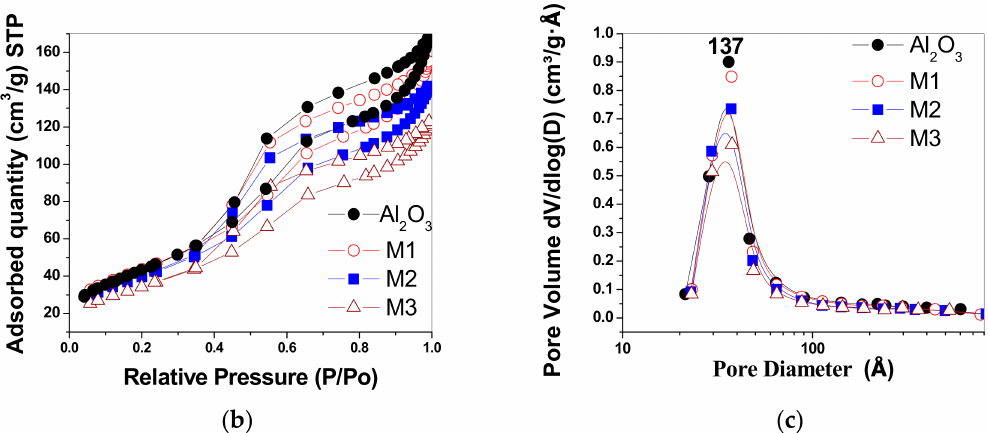
Figure 3. ( a ) SEM micrographs of alumina samples and supported birnessite. Note the rough surface when the manganese oxide is on the support. ( b ) N 2 adsorption–desorption isotherms. ( c ) Mesopore